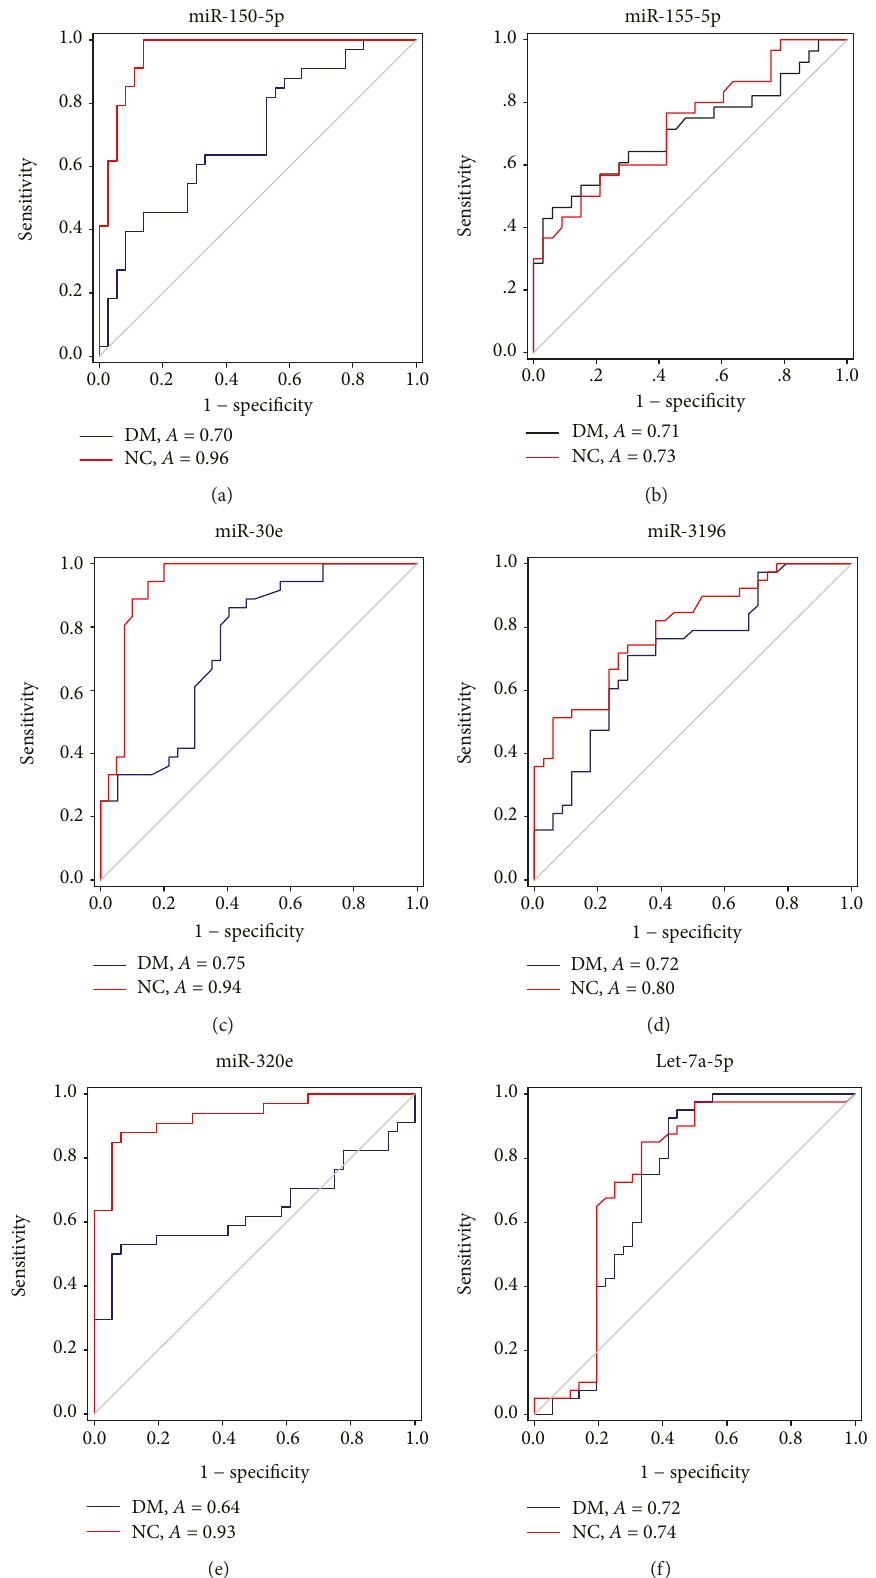
Figure 3: The ROC curve was constructed to evaluate the diagnostic performance of plasma miRNAs: (a) miR-155-5p, (b) miR-150-5p, (c) miR-30e, (d) miR-3196, (e) miR-320e, and (f) let-7a-5p. The red lines represent the ROC curves for di ff erentiating DN from NC, while the blue lines represent the ROC curves for di ff erentiating DN from